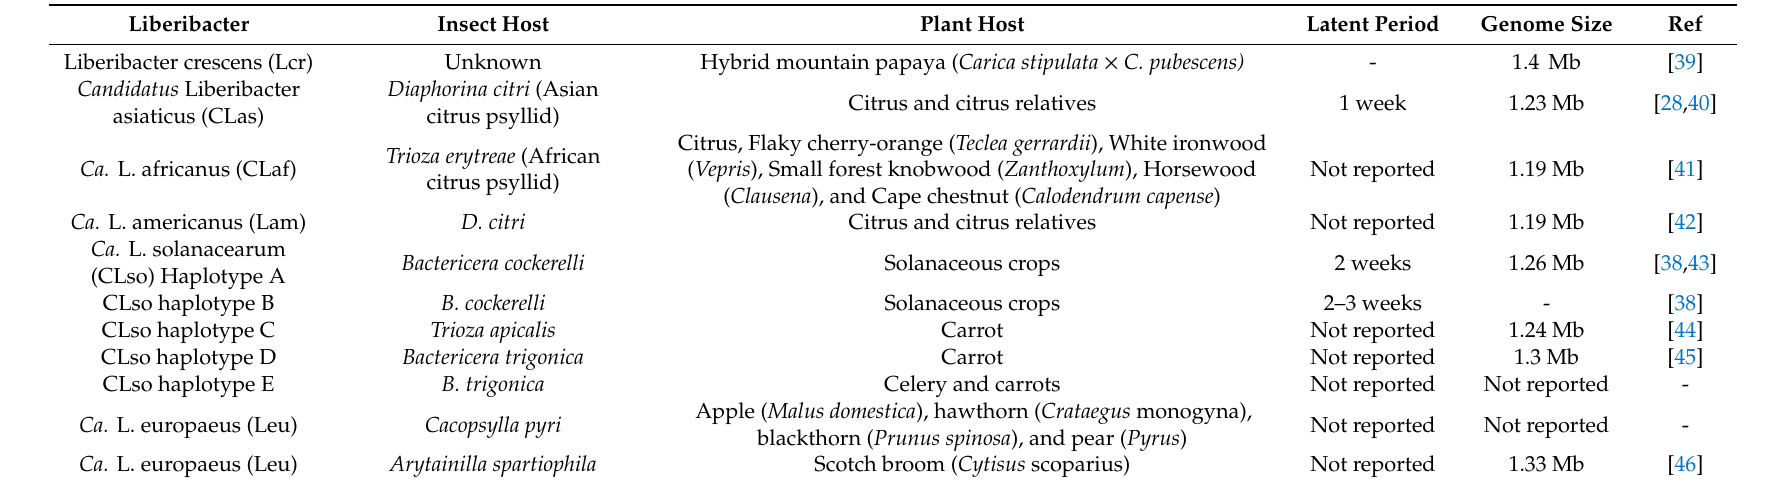
Table 1. Liberibacter-associated diseases, the infected host plants, insect vectors, and other biological and molecular